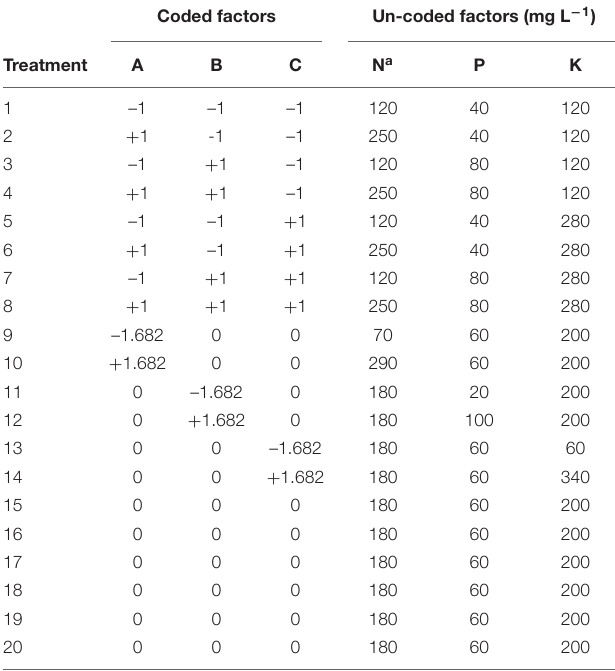
TABLE 1 | Coded and un-coded factors for each treatment of the response surface analysis experiment investigating the effect of nitrogen (N), phosphorus (P), and potassium (K) rates on cannabis production in deep-water culture.